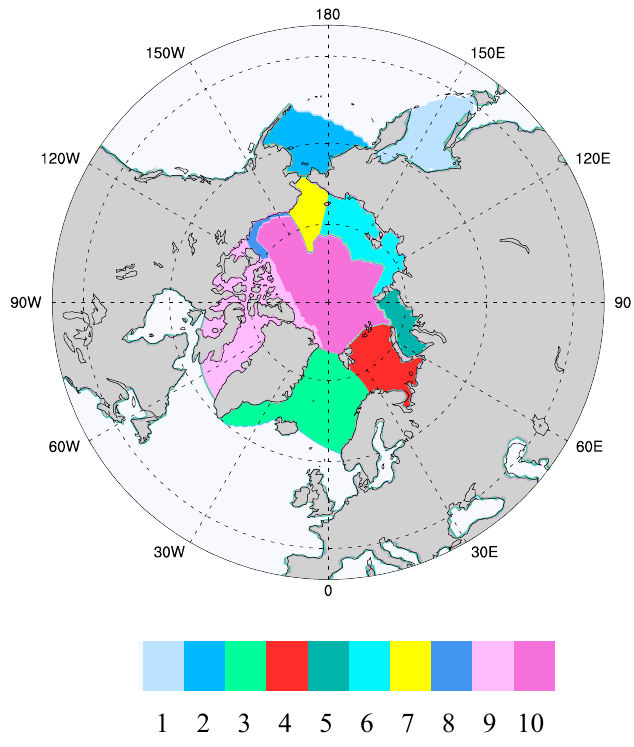
Figure 1. Ecogeographic zones over which averaging of the CICE results was conducted, and within which the ice algal modeling takes place. (1) Sea of Okhotsk, (2) the Bering Sea, (3) GIN Seas (Greenland, Iceland, Norway), (4) Barents Sea, (5) Kara Sea, (6) Siberian Shelf (combines Laptev and East Siberian), (7) Chukchi Sea, (8) Beaufort Shelf, (9) Canadian Archipelago, (10) Central Arctic. This system is an adaptation of the ecological geography developed originally by Carmack and Wassmann [32] and later extended in the work of Deal et al. [13].